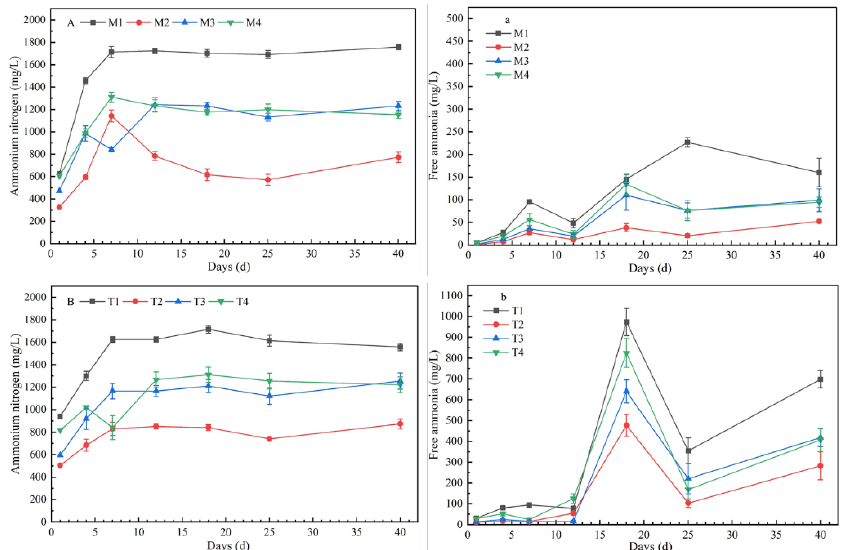
Figure 3. Concentrations of ammonium nitrogen (AN) and free ammonia (FA) under mesophilic conditions ( A , a ) and thermophilic conditions ( B , b ) (note: the data were the mean of three repetitions, and error bars indicated standard deviation. A and a represent concentrations of AN and FA at mesophilic conditions, B and b represent concentrations of AN and FA at thermophilic conditions.)